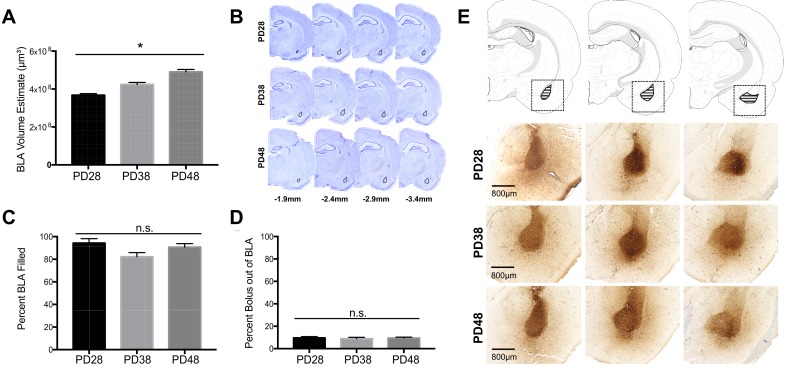
BLA volume and BDA anterograde tracer bolus sites.The average volume of the BLA significantly increased with age (A) as quantified via Cresyl Violet staining of adjacent tissue sections (B). As there were no significant differences as a function of sex or rearing condition on BLA volume estimates at each age group, data were collapsed for each age with a final number of n = 16 per age group. Anatomical coordinates located below Nissl-stained sections (B) indicate the approximate distance (in mm) from Bregma. There were no significant differences in the percent of BLA filled by the BDA anterograde tracer bolus between ages (C), nor was there any significant difference in the amount of bolus located outside of the BLA structure (D). n = 6–9 per group (C; D) before collapsing within each age due to a lack of differences as a function of sex or rearing condition at each age (therefore, the number of data points per age group for analyses in C and D were 24–36). Panel (E) shows representative photomicrographs of BDA bolus across the extent of the BLA for each age examined. Atlas modified from Swanson (2018).Figure 1—source data 1.Raw Bolus Volume Data.